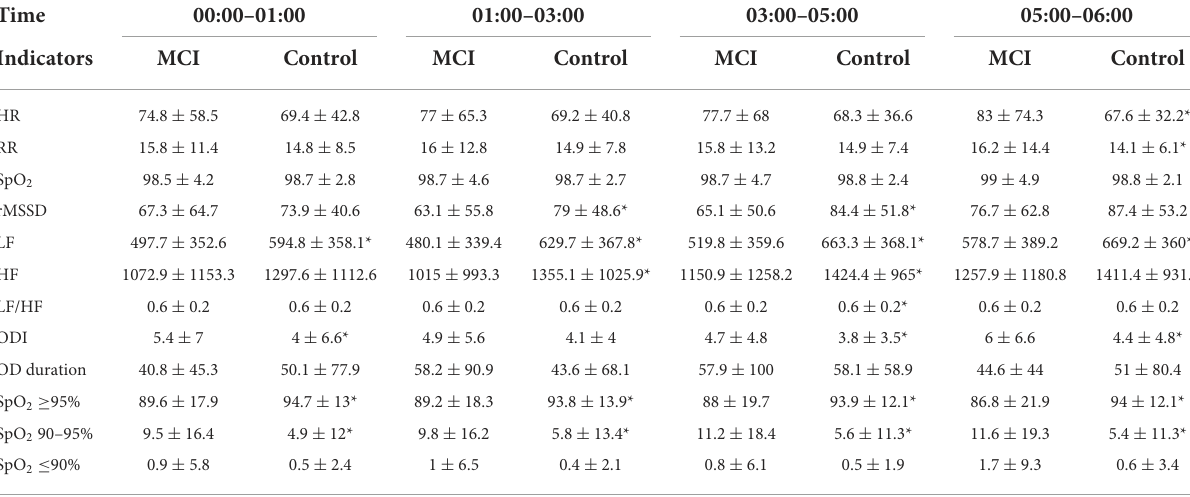
TABLE 6 Distribution of each index of physiological function between groups in each time period.